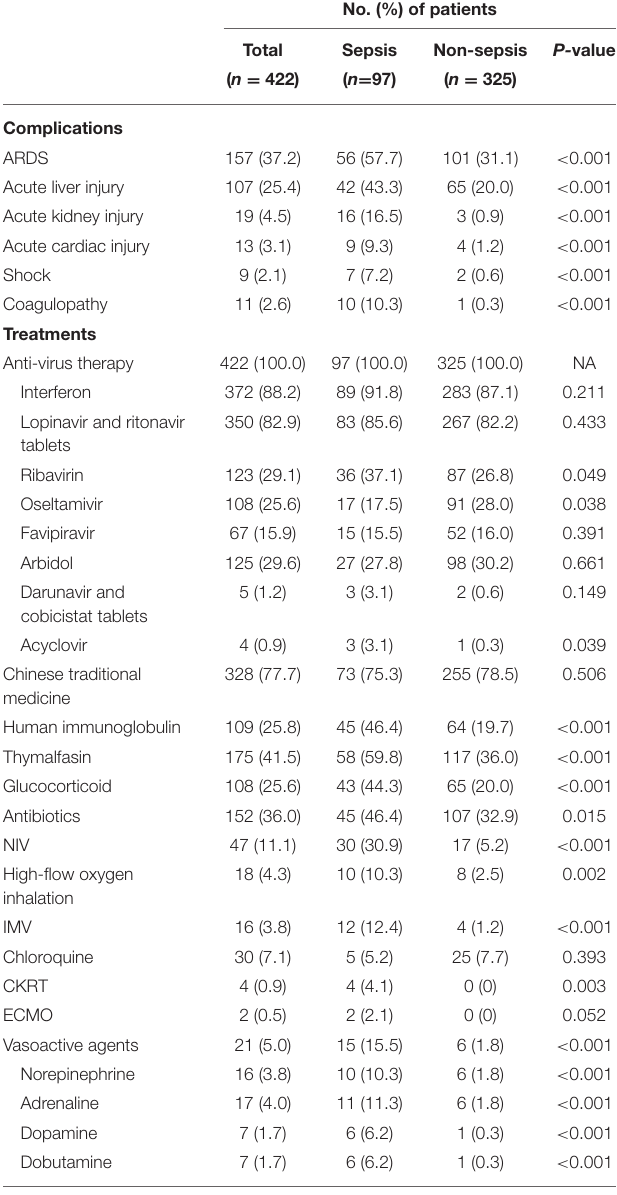
TABLE 2 | Complications and treatments of patients with COVID-19 in Shenzhen,